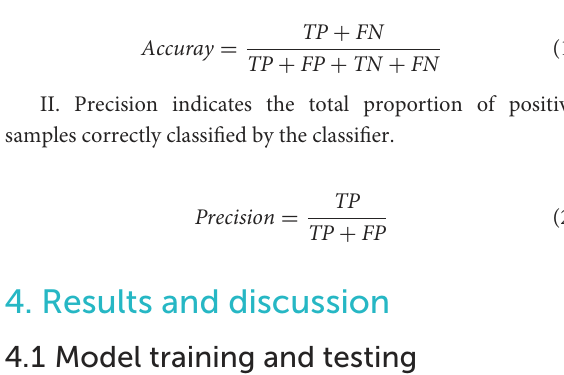
and negative samples refer to samples that do not belong to a certain category).